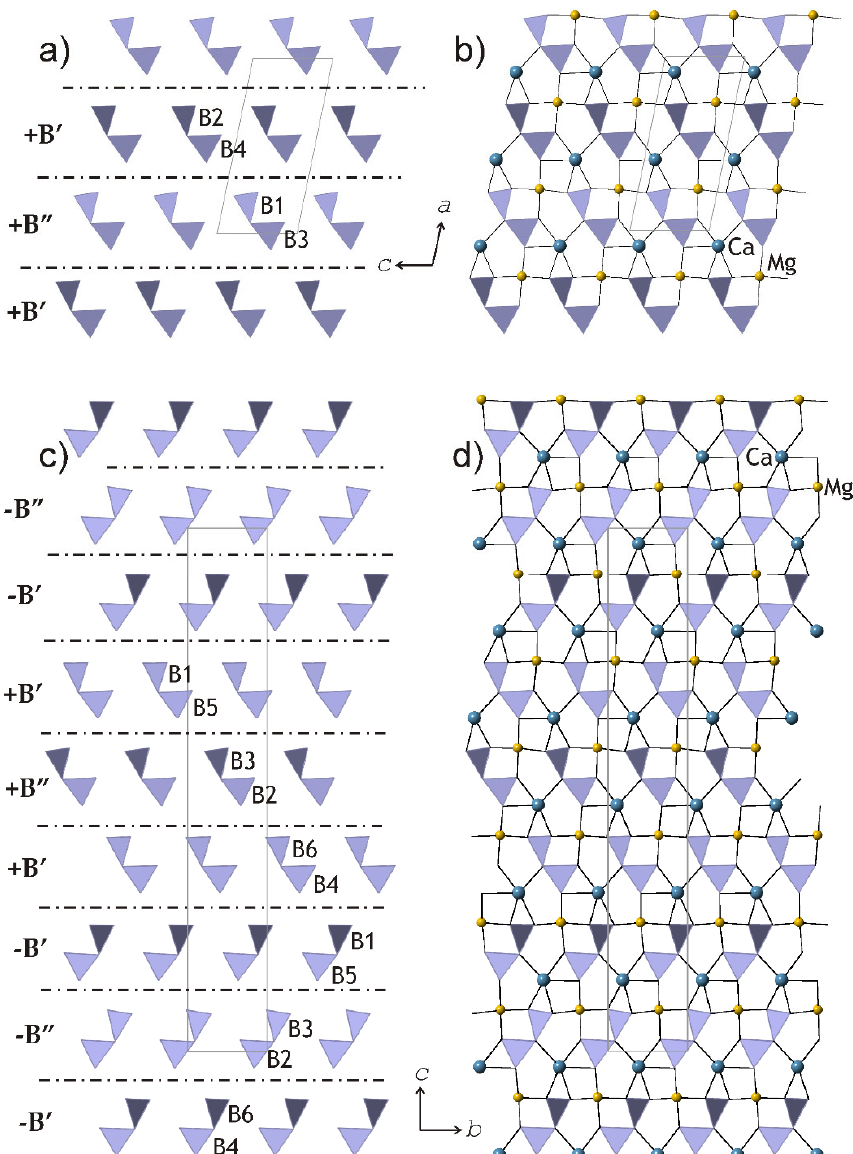
Figure 10. The slices of the crystal structures of clinokurchatovite ( a , b ) and kurchatovite ( c , d ), which consist of diborate groups. The dot-and-dash lines in ( a ) and ( c ) indicate the relative positions of the B’ and B” of different orientations (distinguished by the ‘+ and ‘ − ’ signs). After